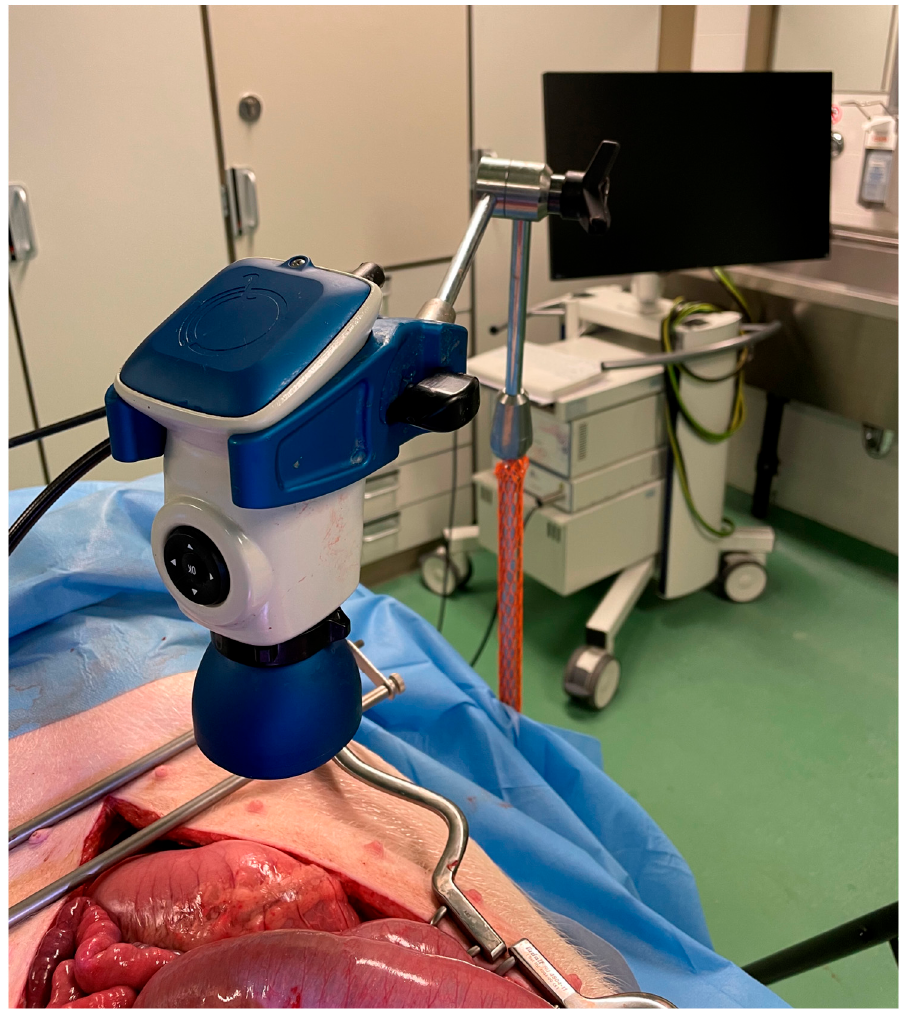
Figure 1. Set-up during experiments: The abdominal cavity was accessed via a midline laparotomy to expose the regions of interest (i.e., small bowel and mesenteric lymph nodes). The distal lens of the QUEST camera ® 3 (Quest Medical Imaging, Middenmeer, The Netherlands) was positioned 15 cm above the regions of interest. External light interference was avoided during the acquisition of images.